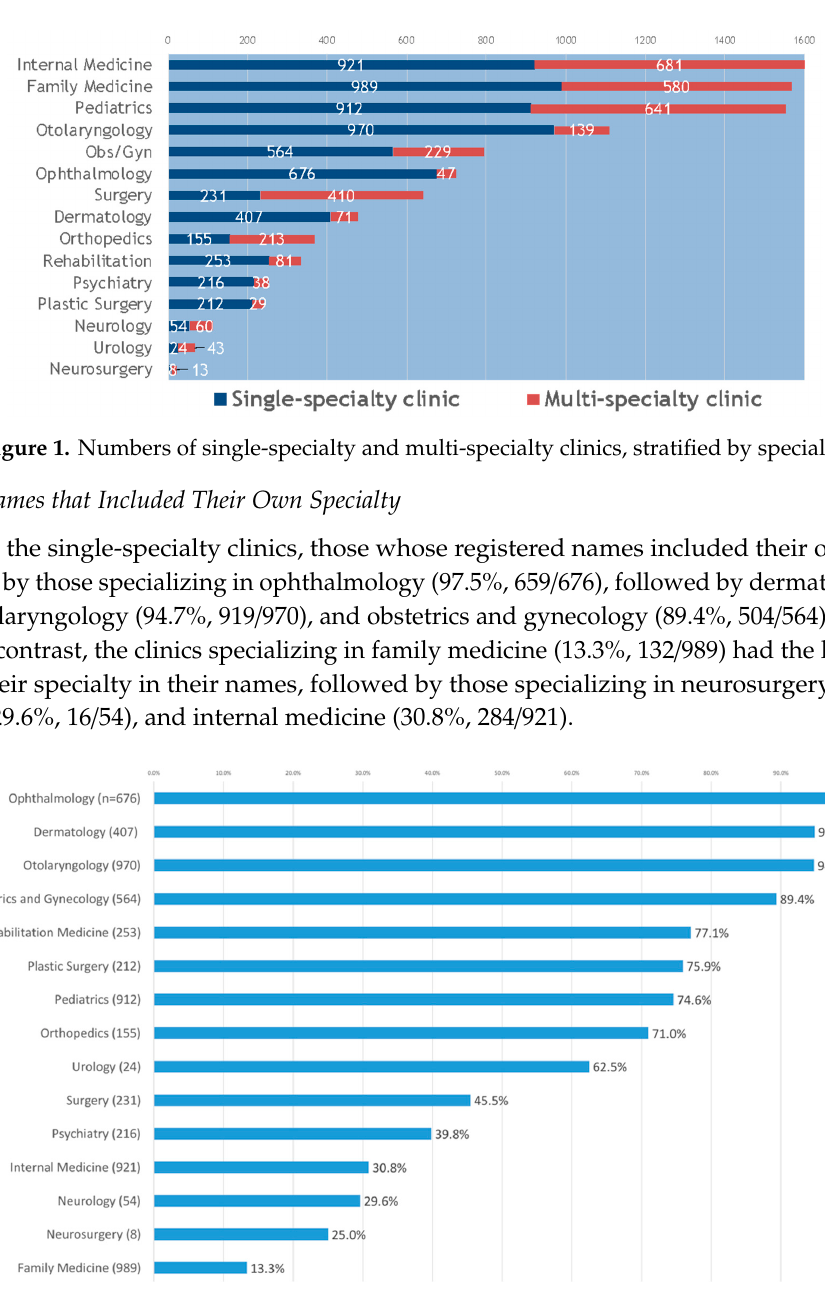
Figure 2. Percentages of single-specialty clinics containing their specialty in their registered clinic